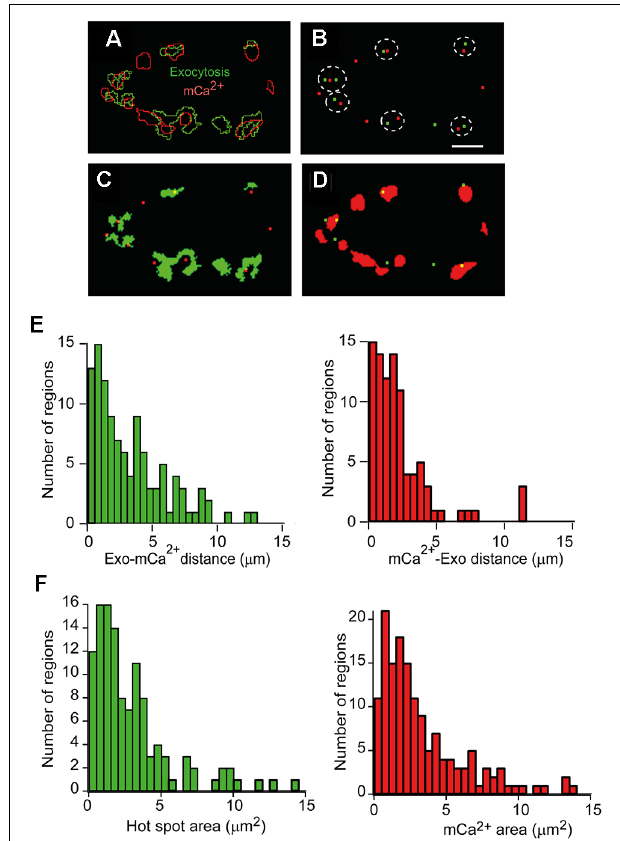
FIGURE 2 | Quantitative analysis of the spatial relationship between exocytosis hot spots and mCa 2+ . (A) Representative image showing the outlines of hot spots of exocytosis regions (green) and mCa 2+ increase regions (red) superimposed after a 500 AP train (50 Hz) of stimulation. (B) Spatial distribution of exocytosis hot spots centroids (green) and mCa 2+ (red) centroids of the terminal in A . The dotted lines indicate the nearest neighbors between exocytosis hot spots and mCa 2+ . (C) Location of mCa 2+ centroids (red) and the exocytosis hot spot areas (green). (D) Location of exocytosis hot spots centroids (green) and the mCa 2+ areas (red). Calibration bar (A–D) : 5 µ m. (E) Distance distribution between nearest-neighbor centroids in 11 terminals (four mice). Left: exocytosis-mCa 2+ distance. Right: mCa 2+ -exocytosis hot spots distance. (F) Frequency histograms of the exocytosis hot spots areas (left) and mCa 2+ region areas (right; 14 terminals, six mice) in each